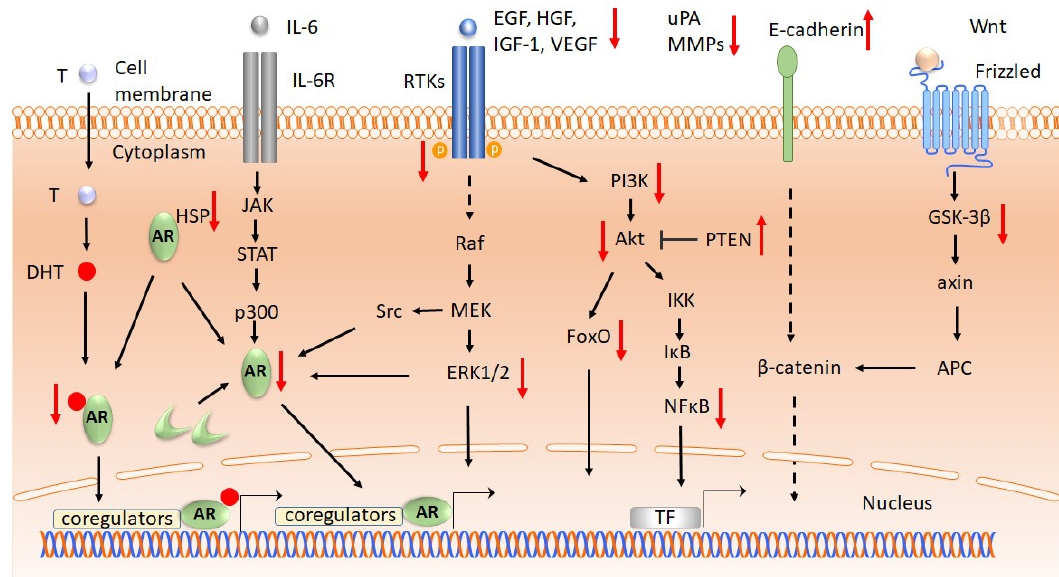
Figure 3. The effects of polyphenols on signaling pathways in prostate cancer. In the canonical pathway ARs are activated by DHT binding. AR can be transactivated in the absence of DHT through different signaling pathways: increased activity of RTK or interleukin receptors and their signaling pathways, modifications of the coregulatory proteins, or constitutively activated AR [115,126]. Ligand binding to RTK activates PI3K/Akt kinases, which trigger the activation of IKK. This pathway induces phosphorylation of I κ B, resulting in its ubiquitylation and proteasome-mediated degradation. NF- κ B is maintained in the cytoplasm by the interaction with I κ B, and degradation of I κ B activates NF- κ B, which in turn is enabled to enter the nucleus and activate the genes involved in cell survival [127,128]. For simplification, the canonical pathway of NF- κ B activation that takes place through the members of tumor necrosis factor receptors or interleukin receptors is omitted from the figure [129]. Similarly, the canonical pathway of PI3K/Akt signaling is not presented. Polyphenols might modulate the levels of signaling molecules in prostate cancer by decreasing or increasing their levels. Polyphenols downregulate AR (quercetin, genistein, resveratrol, EGCG), HSP90 (genistein), IGF-1 (apigenin), EGFR (curcumin, resveratrol), HER2 (resveratrol), ERK (apigenin, gallic acid, EGCG), phosphorylated PI3K (apigenin, curcumin, resveratrol), phosphorylated Akt (apigenin, CAPE, gallic acid, resveratrol), FoxO (apigenin), NF- κ B (apigenin, curcumin, gallic acid, EGCG), GSK-3 β (CAPE), VEFG (apigenin, genistein, quercetin, EGCG), uPA (apigenin), MMPs (apigenin, gallic acid, EGCG, genistein) and upregulate PTEN (resvetratol) and E-cadherin (apigenin). Legend: AR , androgen receptors; T, testosterone; DHT, dehydrotestosterone; HSP, heatshock protein; RTK, receptor tyrosine kinase; Raf, rapid accelerated fibrosarcoma protein; MEK, mitogen activated protein kinase, kinase; ERK1/2, extracellular